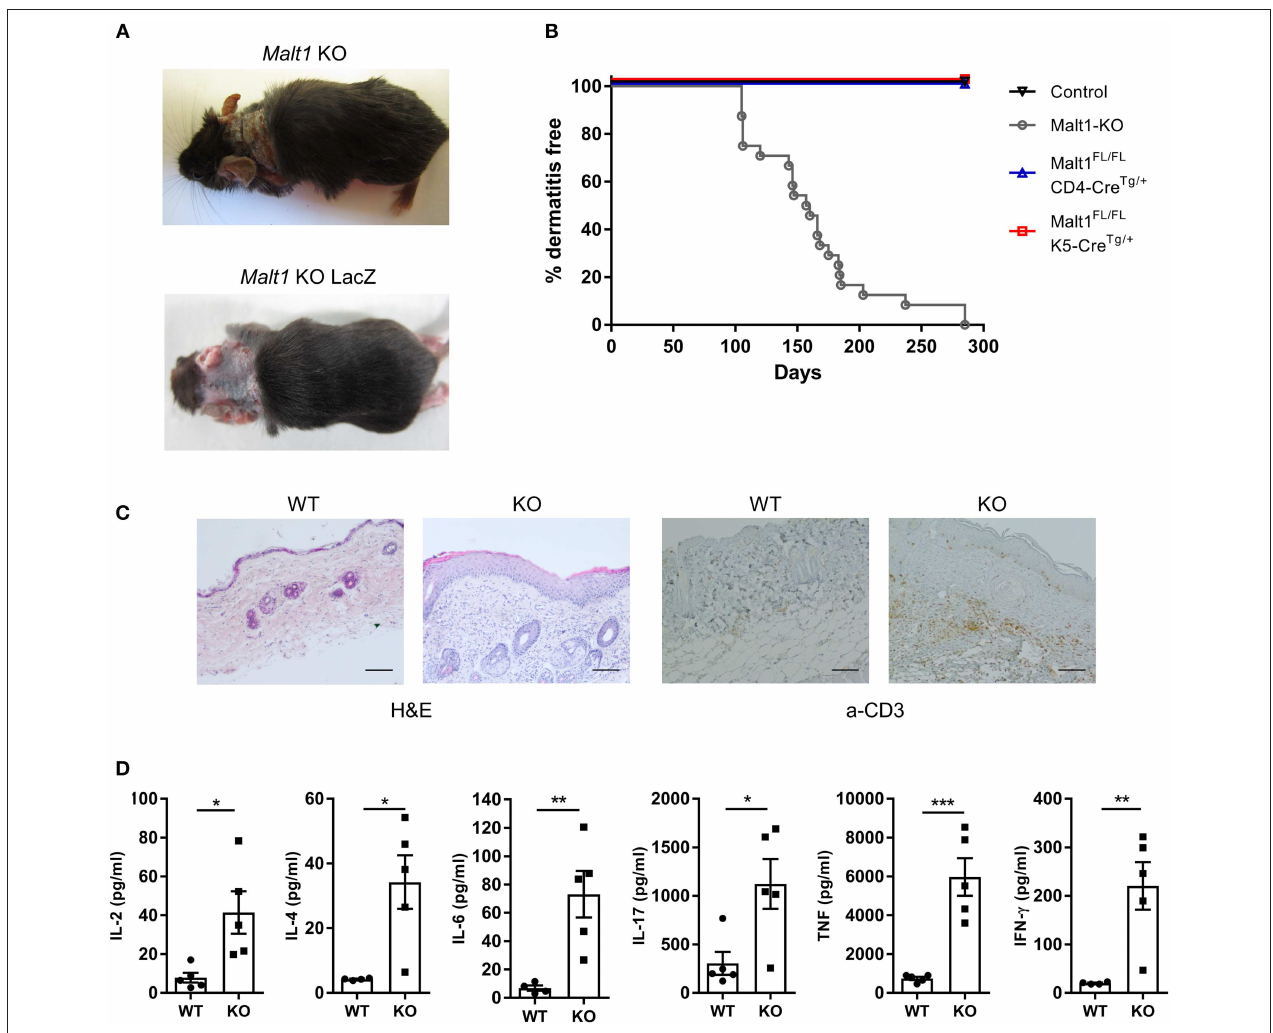
FIGURE 1 | Malt1 -KO mice develop skin lesions at late age accompanied by elevated serum cytokine levels. (A) Skin lesion in the neck of a Malt1 -KO and Malt1 -KO LacZ mouse. (B) Incidence of dermatitis in Malt1 -KO mice ( n = 8 for controls, n = 24 for Malt1-KO , n = 6 for Malt1 FL / FL CD4-Cre Tg / + , and n = 6 for Malt1 FL / FL K5-Cre Tg / + ). (C) H&E staining on WT and Malt1 -KO skin (scale bar 100 µ m), showing epidermal thickening and parakeratosis in Malt1 -KO skin and α -CD3 staining on WT and Malt1 -KO skin (scale bar 100 µ m), showing increased CD3 staining in Malt1 -KO skin. (D) Elevated serum levels of IL-2, IL-4, IL-6, IL-17, IFN- γ , and TNF in Malt1 -KO mice compared to WT mice (both n = 5 and > 30 weeks, and Malt1 -KO mice have AD). Open circles (WT) and black squares (KO) represent individual mice. The mean ± SEM is indicated on the graphs. The statistical significance between groups was calculated with an unpaired 2-tailed Student’s t -test: * P < 0.05, ** P < 0.01, and *** P <